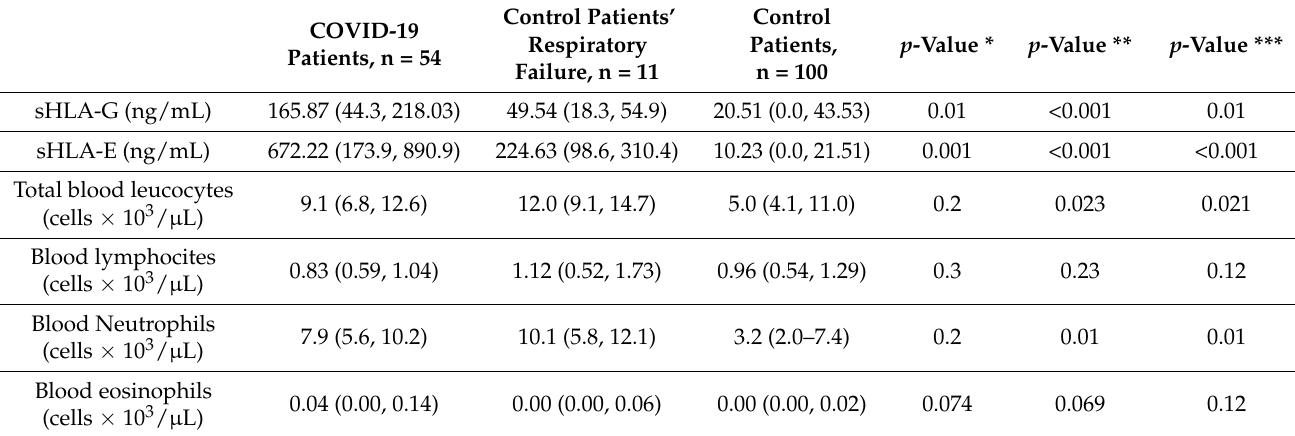
Table 2. sHLA-G and sHLA-E levels and blood inflammatory cell counts at baseline (T1) in COVID-19 patients and